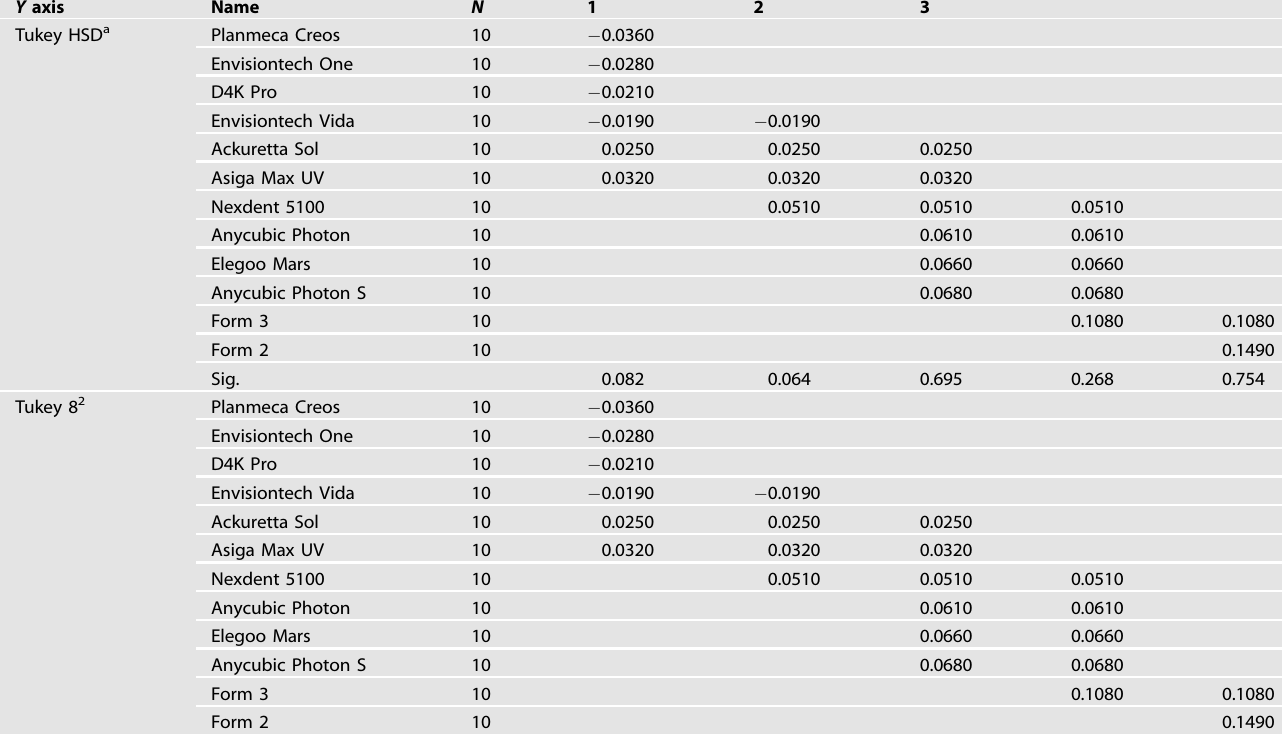
Table 4. Tukey homogenous subsets of compared means for the Y measurement (subset for alpha = 0.05). Y axis